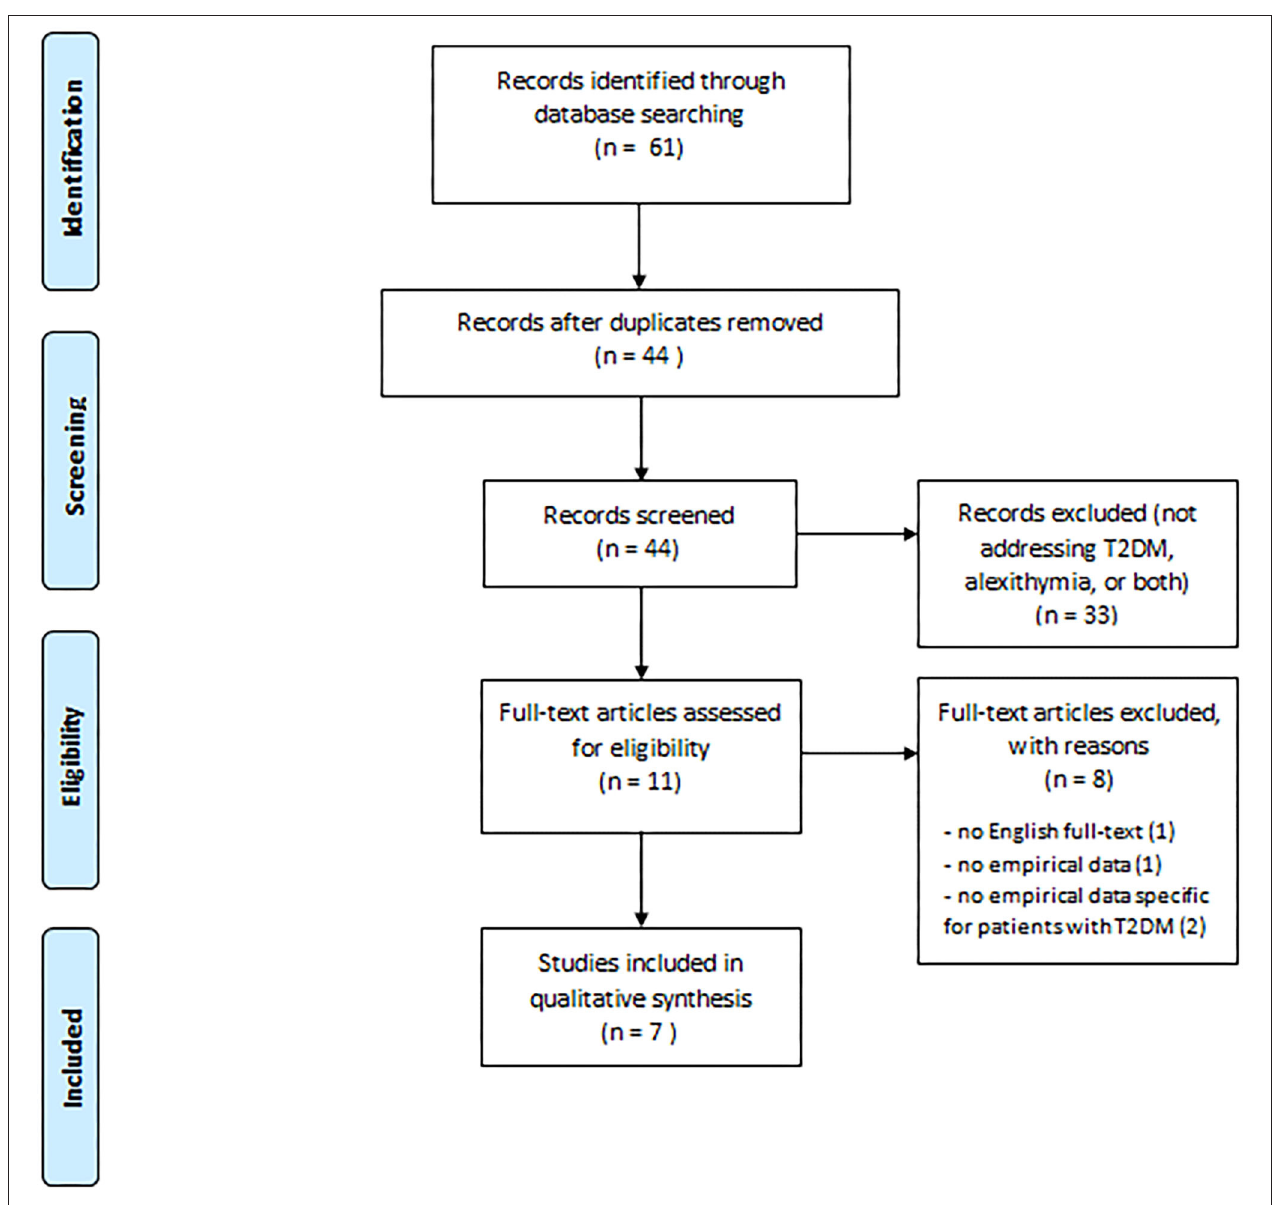
FIGURE 1 | PRISMA flow chart of the systematic